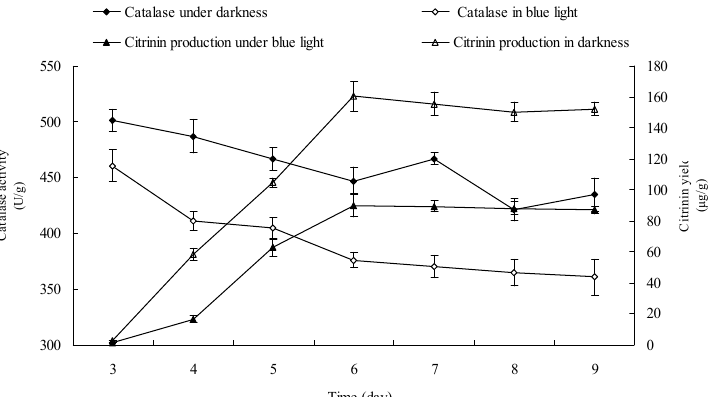
Figure 10. Effect of blue light on catalase activity of Monascus in liquid fermentation. Two grams of wet Monascus mycelium treated with blue light or kept in darkness were added to 18 mL 0.2 mol·mL − 1 , pH 7.8 phosphate buffer from fermentation of day 3. Catalase activity of 10% tissue homogenate